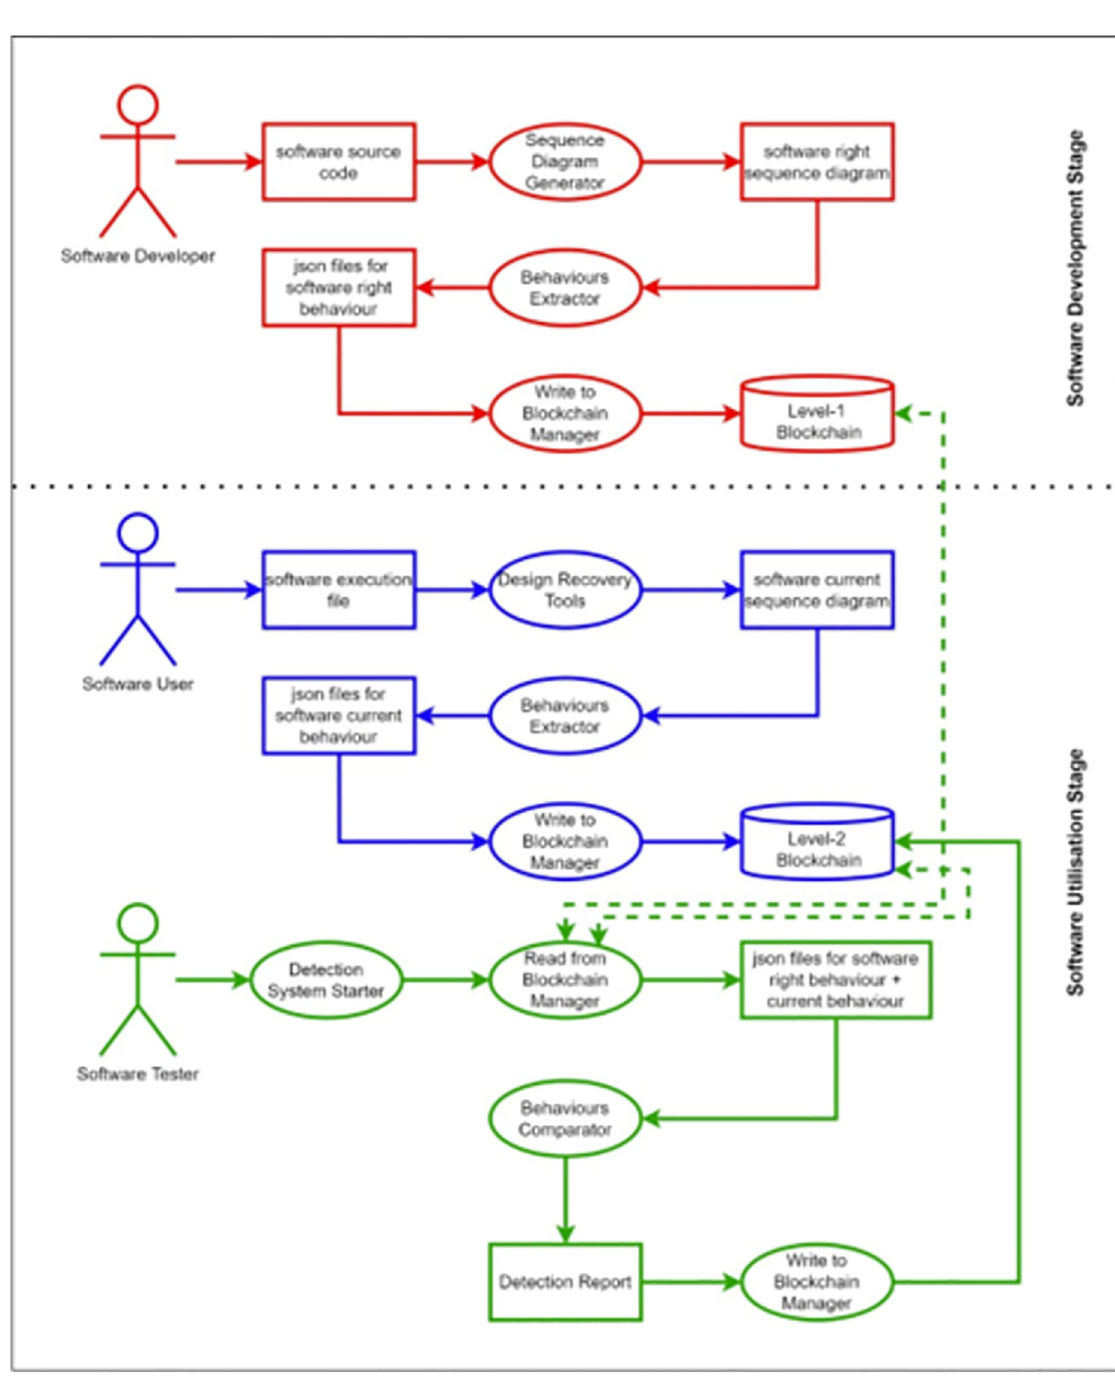
Fig 8. The high-level structure and workflow of the proof of